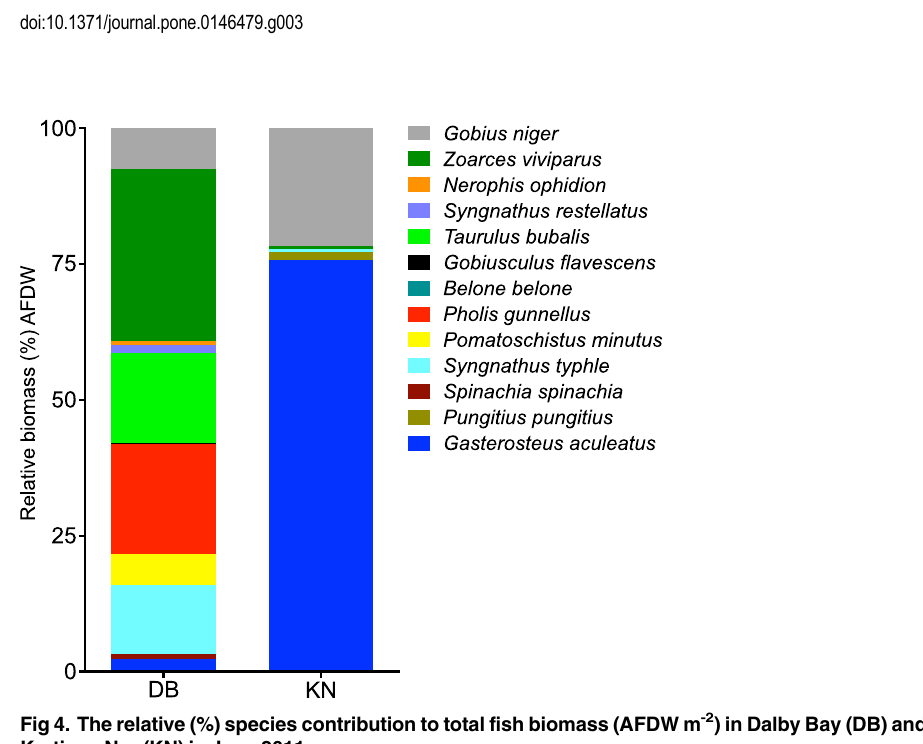
Fig 3. Faunal biomass (A) and abundance (B) in Dalby Bay and Kertinge Nor in June 2011. Asterisks indicate significant difference between the two sites (t-test < 0.05).